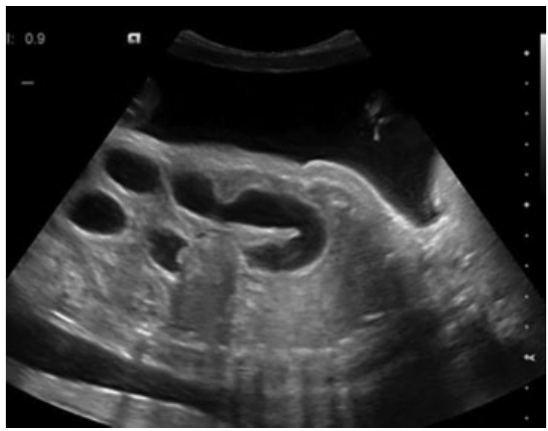
Fig. 1 Fetal ultrasound scan performed at 34 weeks. Note loops of the small bowel visualized in the chest cavity.